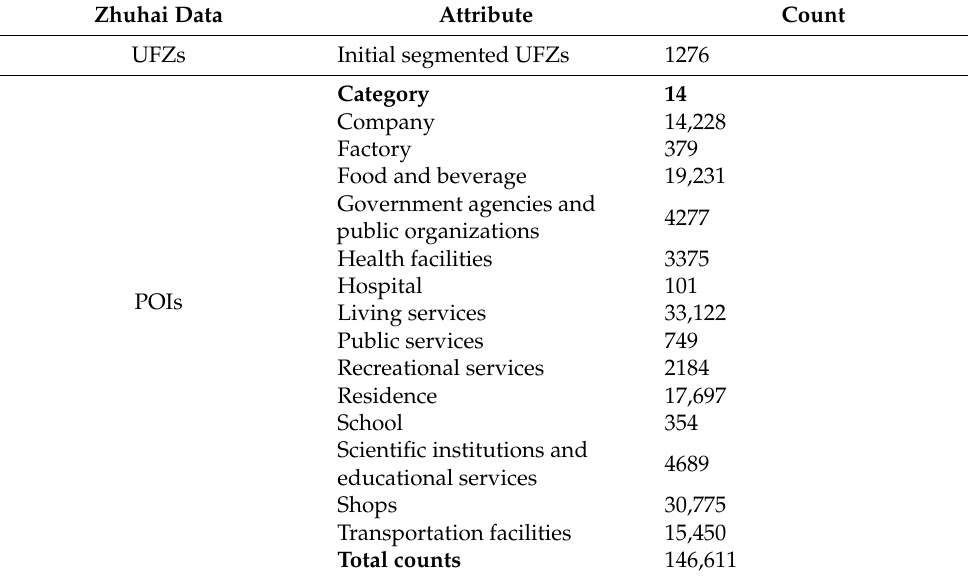
Table 2. Statistics of segmented UFZs and POIs of Zhuhai data.